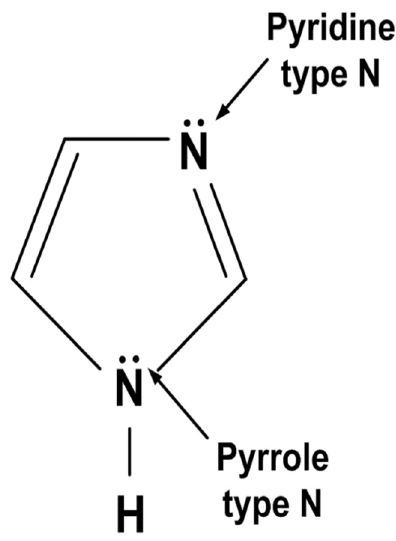
Figure 1. Molecular structure of